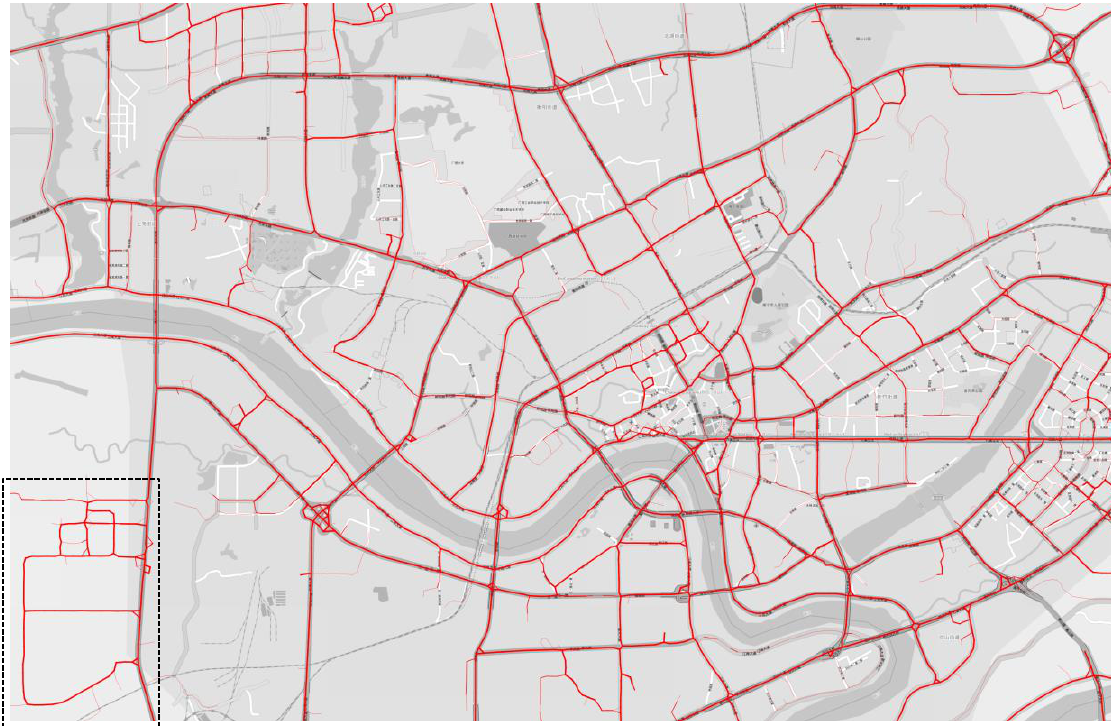
Figure 16. Comparison between road network and street map.